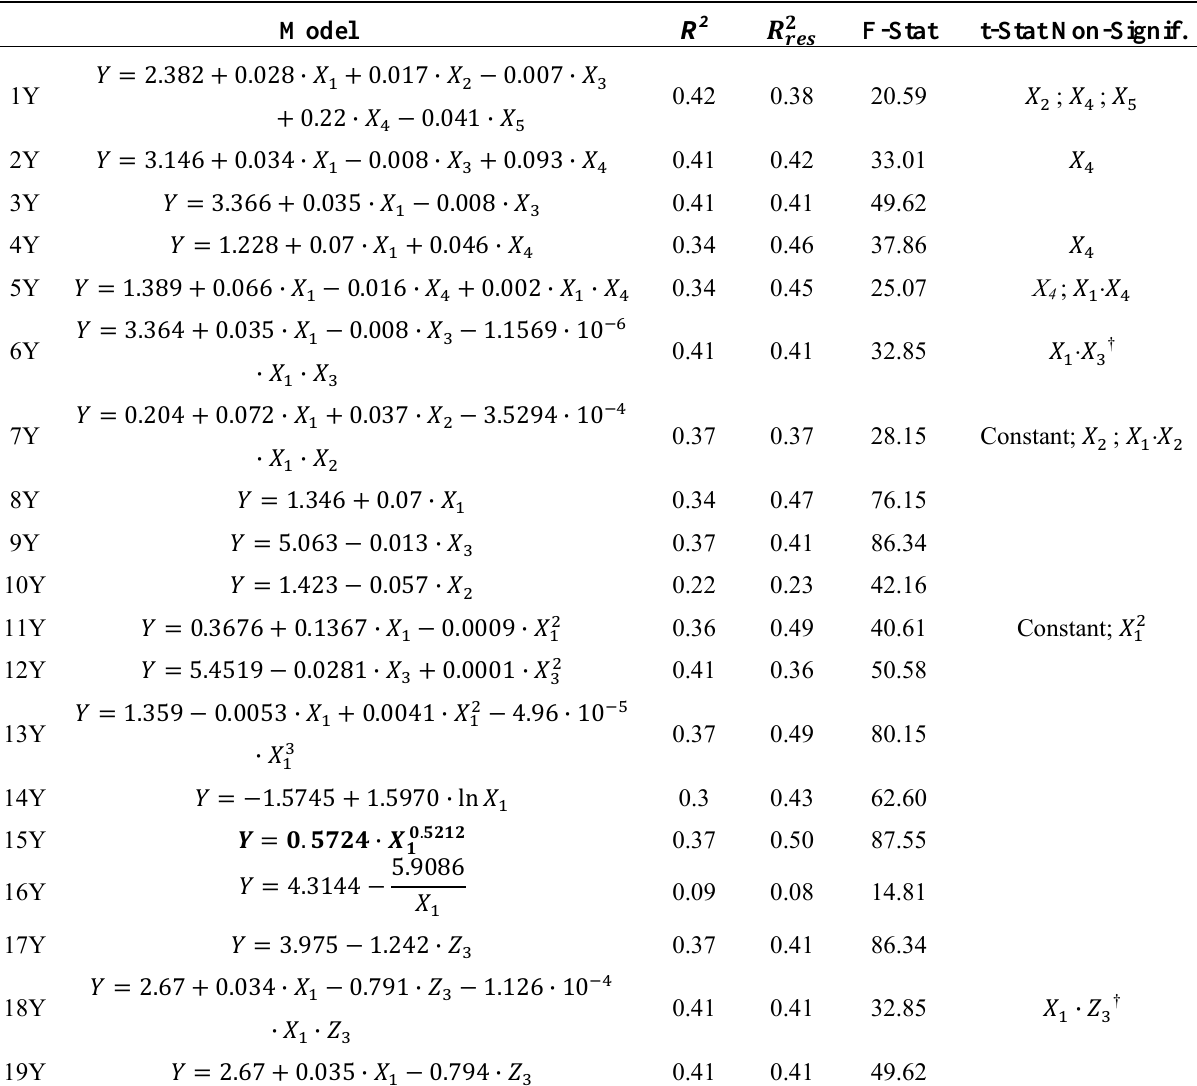
Table 5. Summary table for yield prediction models.